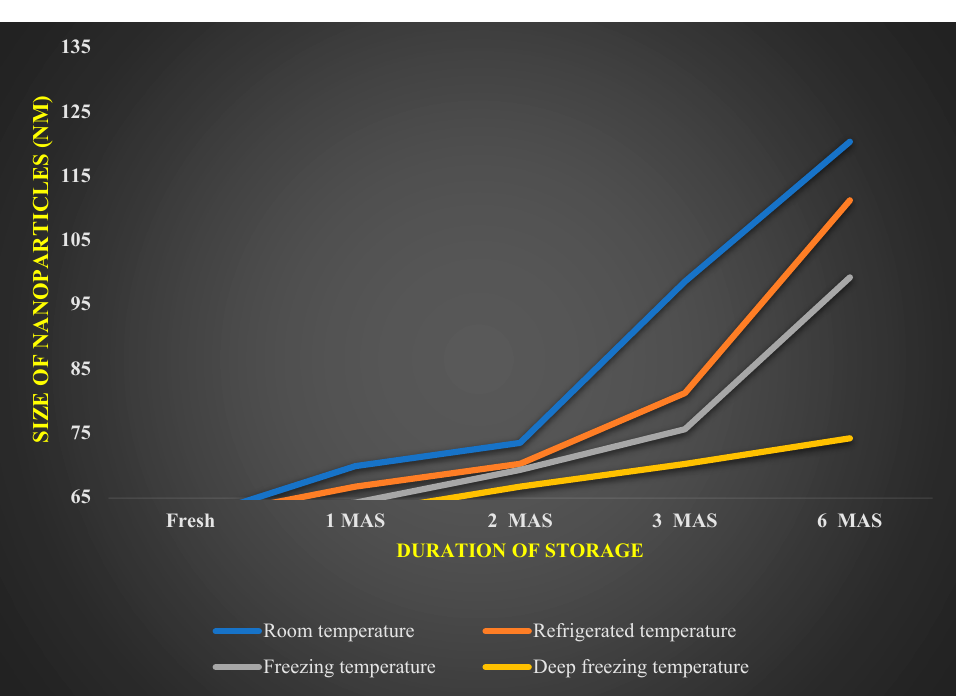
Figure 8. Zeta potential of P. pinnata -based AgNPs.